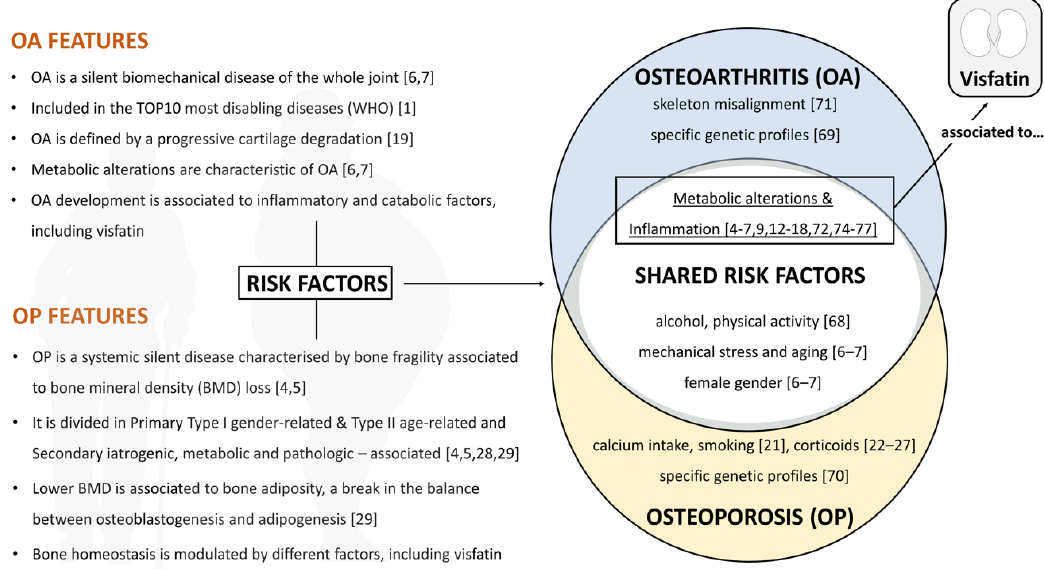
Figure 1. Osteoarthritis (OA) and osteoporosis (OP). OA and OP are two major silent rheumatic diseases with specific features, and are included in the World Health Organization (WHO) disease- disabling lists. Nevertheless, they clearly present different clinical diagnoses and development. OA